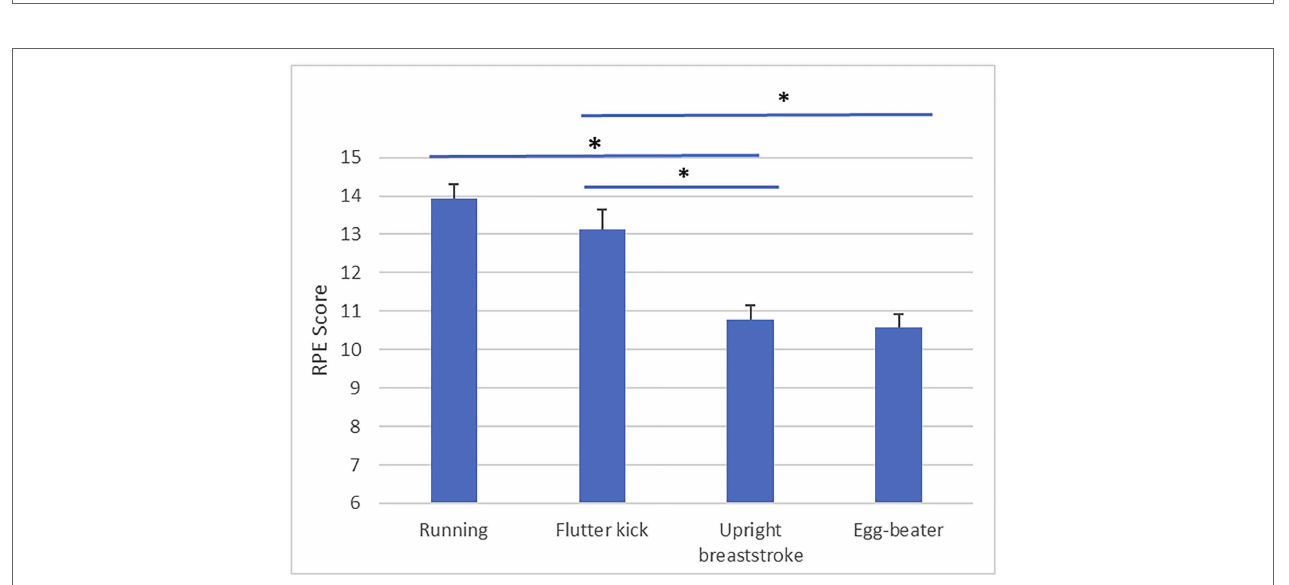
FIGURE 2 | NASA Task load Index (NASA TLX) scores during four treading water techniques in skilled treaders – means and SEs. * Denotes significant difference between techniques ( p corrected < 0.05).